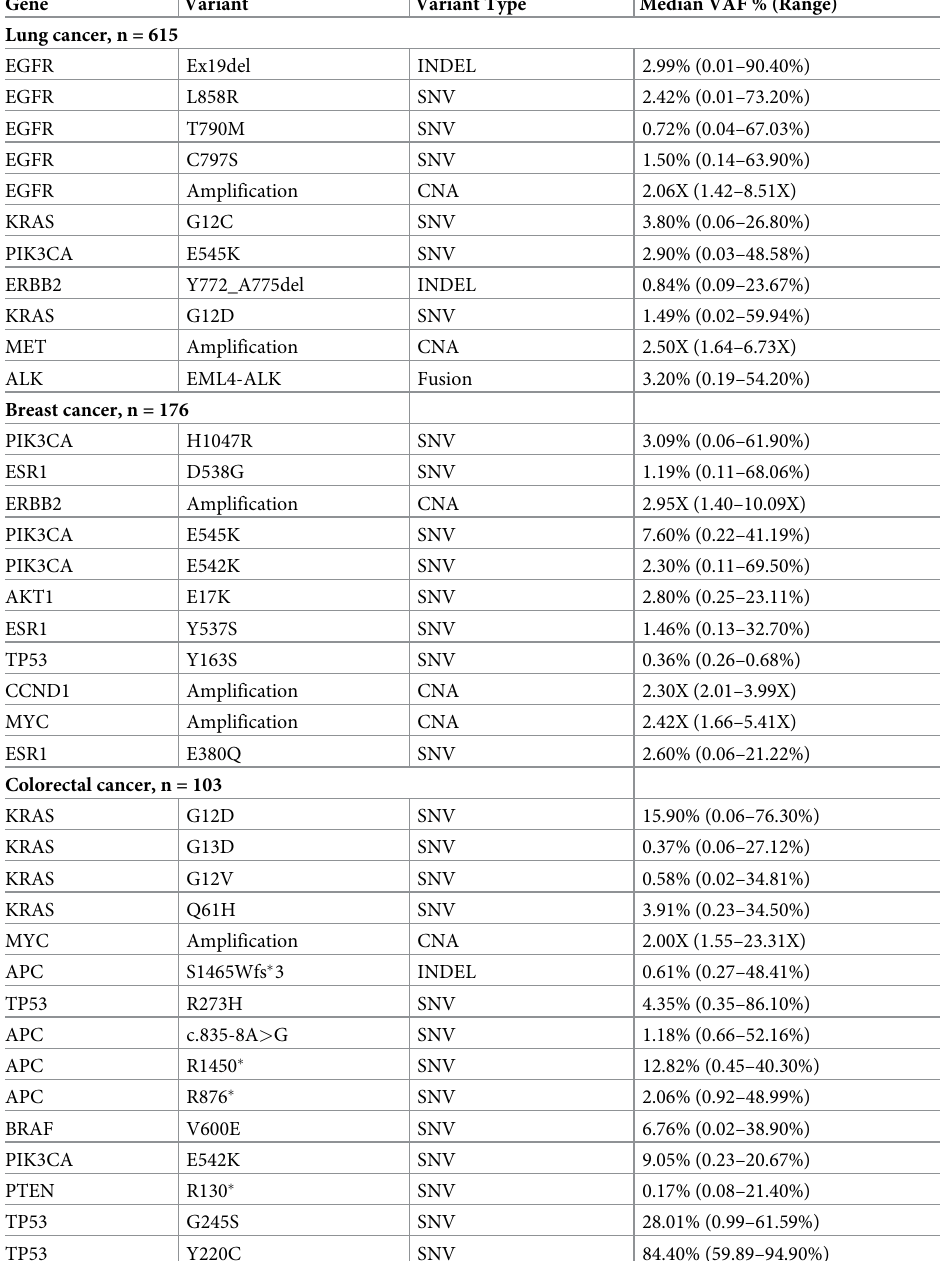
Table 4. Median variant allele fraction (VAF) of top 10 mutated genes in clinical lung, breast, and colorectal